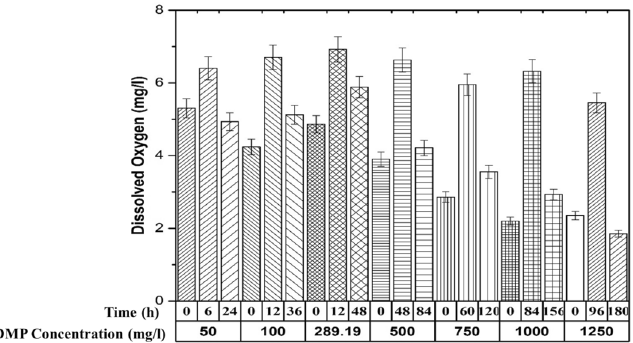
Figure 5. Dissolved oxygen profile during DMP degradation by Micrococcus sp.